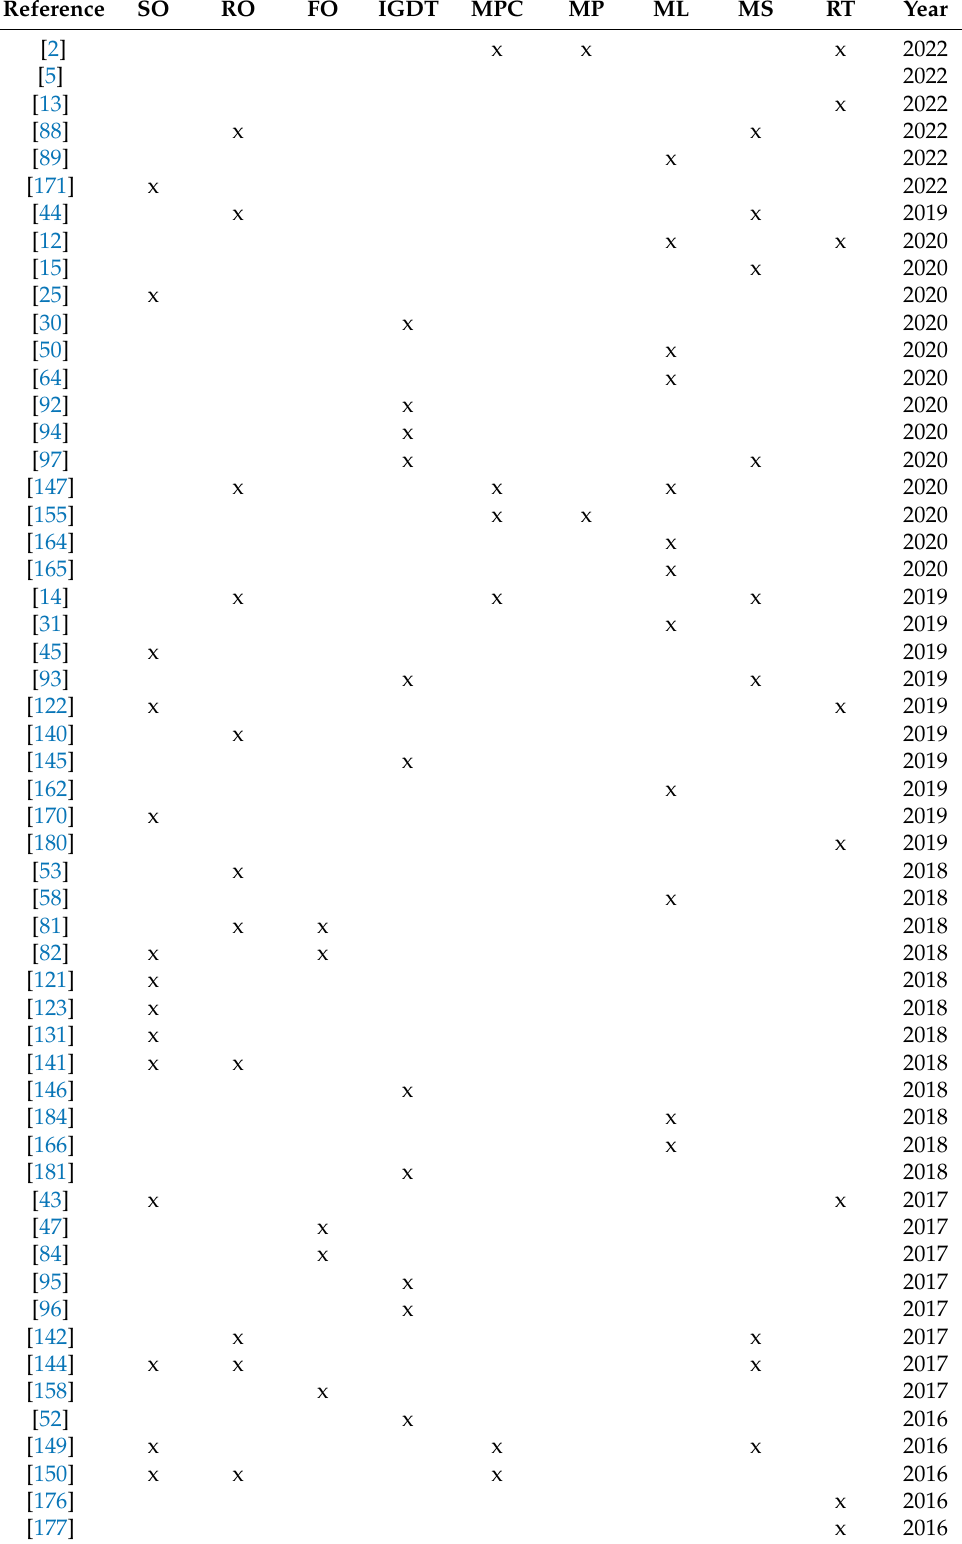
Table 12. Summary of the articles reviewed depending on the optimization technique used. (RO: Robust optimization, SO: stochastic optimization, FO: fuzzy optimization, IGDT: information-gap decision theory, MPC: model predictive control, MP: multiparametric programming, ML: machine learning, MS: multiple stages, RT: real